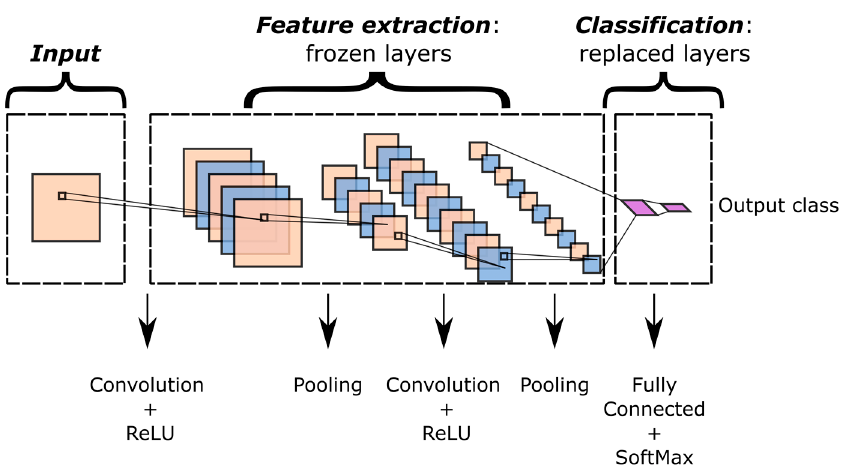
Figure 1. Typical transfer learning framework in CNNs.